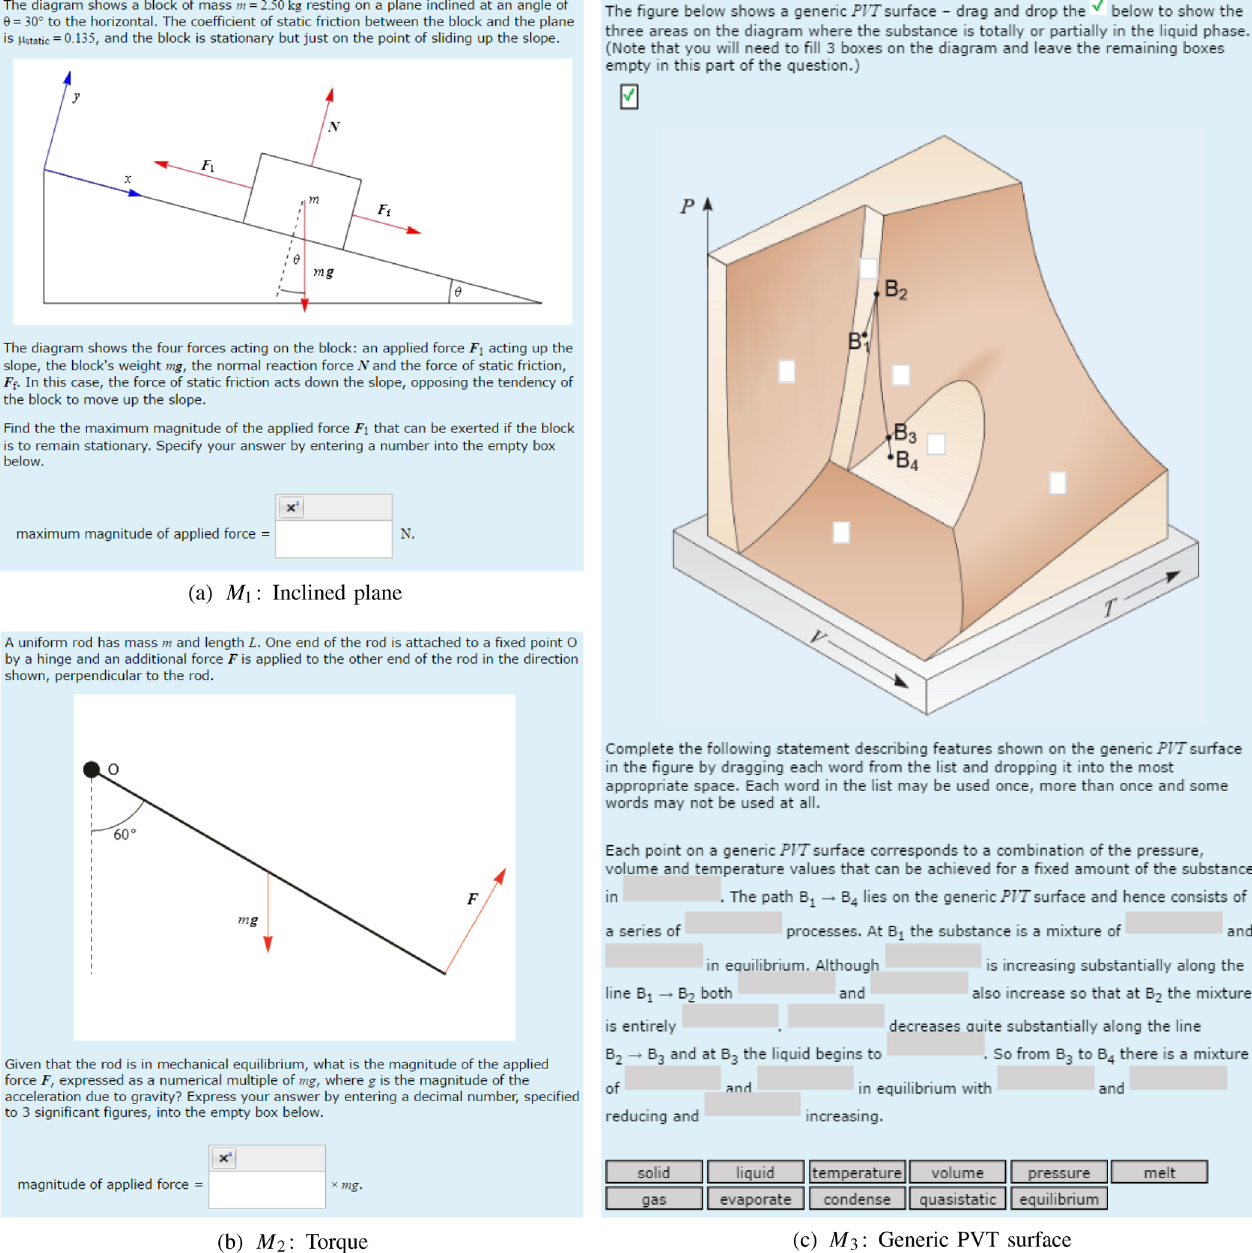
FIG. 1. iCMA items displaying bias in favor of male